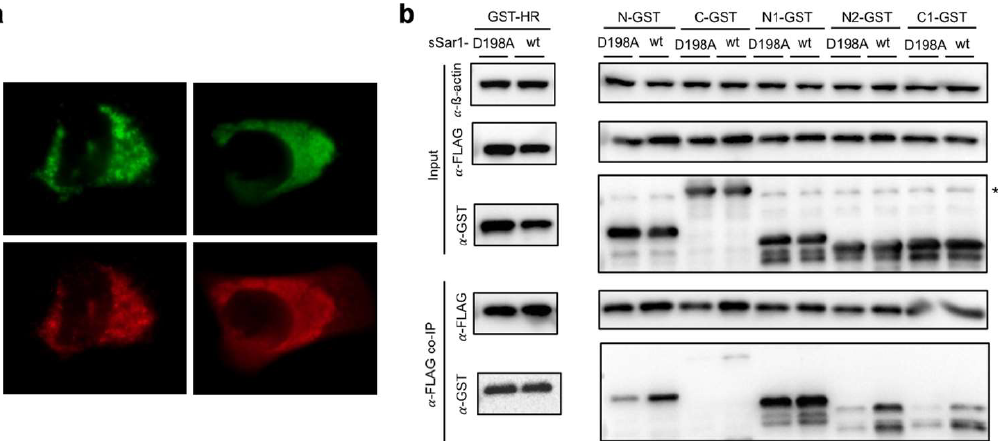
Figure 8. ( a ) msSar1-D198A (red) and mGFP-N2HRC1 (green) were co-expressed in A549 cells, fol- lowed by IFA for identifying recombinant Sar1 with anti-FLAG antibody. ( b ) The variant of